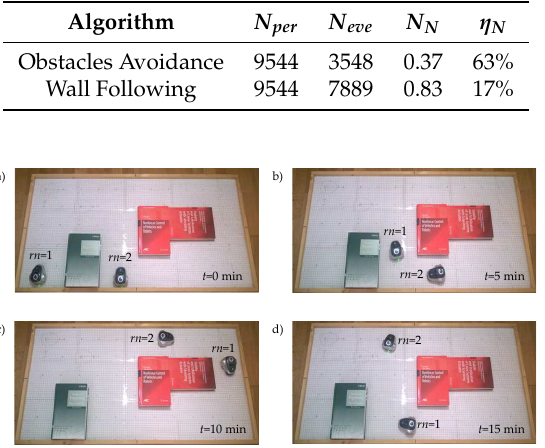
Figure 12. Snapshots of experiment 1. Positions of the robots at: ( a ) t = 0 min; ( b ) t = 5 min; ( c ) t = 10 min; and ( d ) t = 15 min.